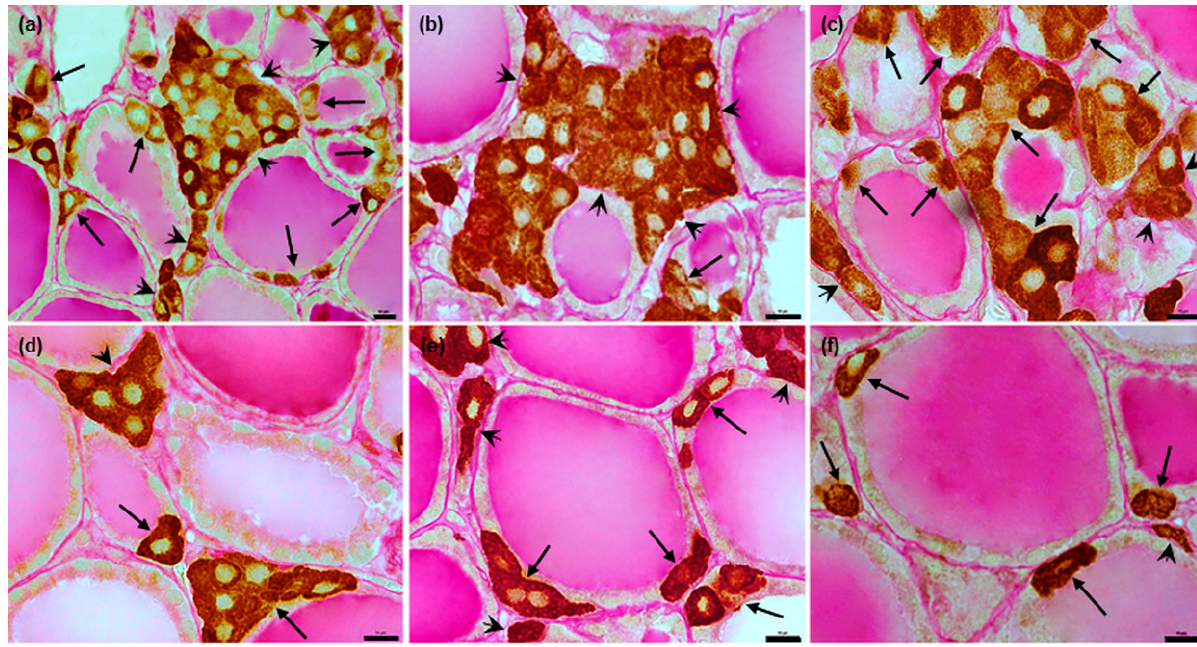
Figure 5. Representative images of canine C thyrocytes position in relation to the follicular wall. ( a , b ): Very large groups of C thyrocytes located epifollicularly. ( c – f ): Smaller cell groups and single cells in both intrafollicular and epifollicular positions. Single C thyrocytes or their groups located intrafollicularly are marked with arrows and those located epifolliculary with arrowheads. Combined anti-calcitonin antibody immunohistochemistry–periodic acid Schiff method, scale bars: ( a – f ) = 10 µm.